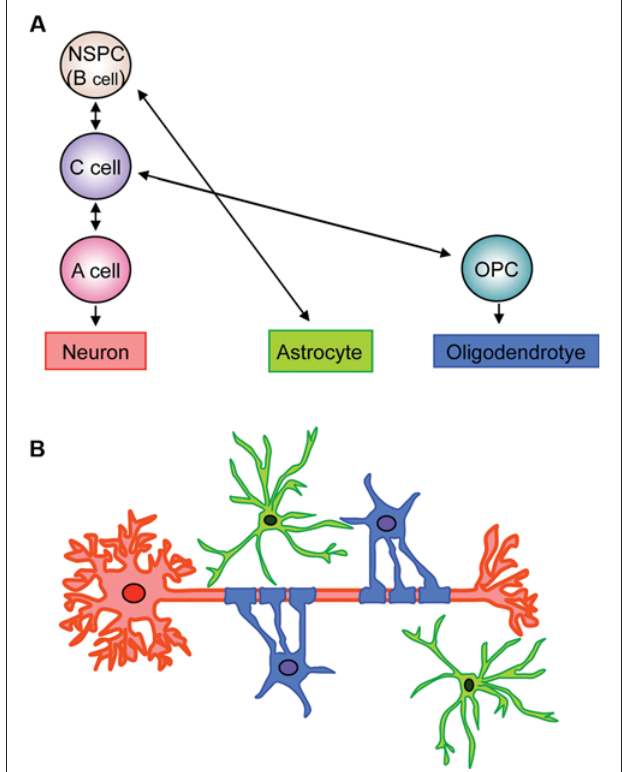
FIGURE 1 | Schematic of fate of neuronal, astroglial, oligodendrocytic lineage cells in V-SVZ . (A) Type B cells retain neuroepithelial trait and function as NSPCs in the V-SVZ. Type B cells slowly divide and give rise to rapidly dividing type C cells (IPCs), which generate neuroblasts (type A cells). The type B cells can also generate astrocytes and Olig2-expressing type C cells. The Olig2-expressing type C cells give rise to highly migratory OPCs, which differentiate into myelinating oligodendrocytes. (B) Neurons, astrocytes, and oligodendrocytes, derived from V-SVZ NSPCs (type B cells), interact with each other to maintain proper neural function. Red: neuron, green: astrocyte, blue: